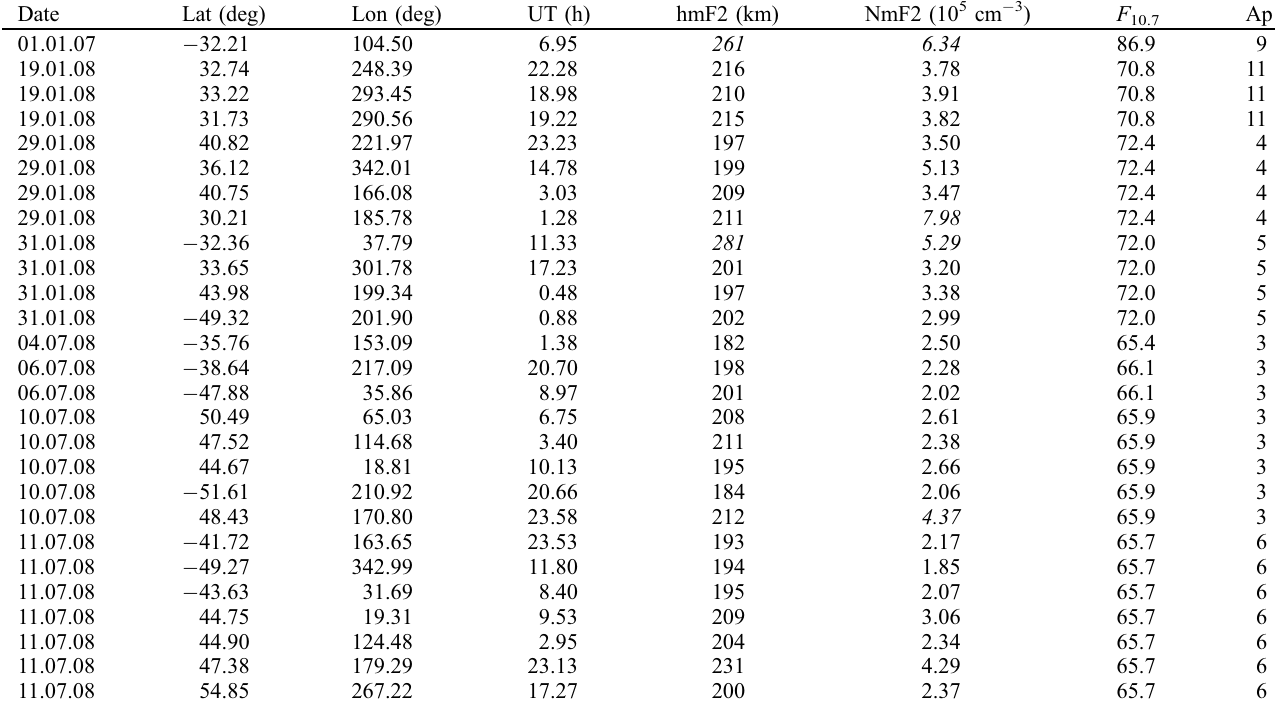
Table A3. The list of cases for which no solutions were found. For the explanation of symbols see Table A1 Abnormally large hmF2 and NmF2 values are given in italic.